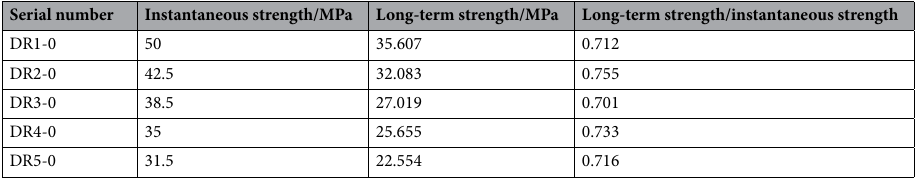
Table 3. Long-term strength of white sandstone damaged by unloading before peak.